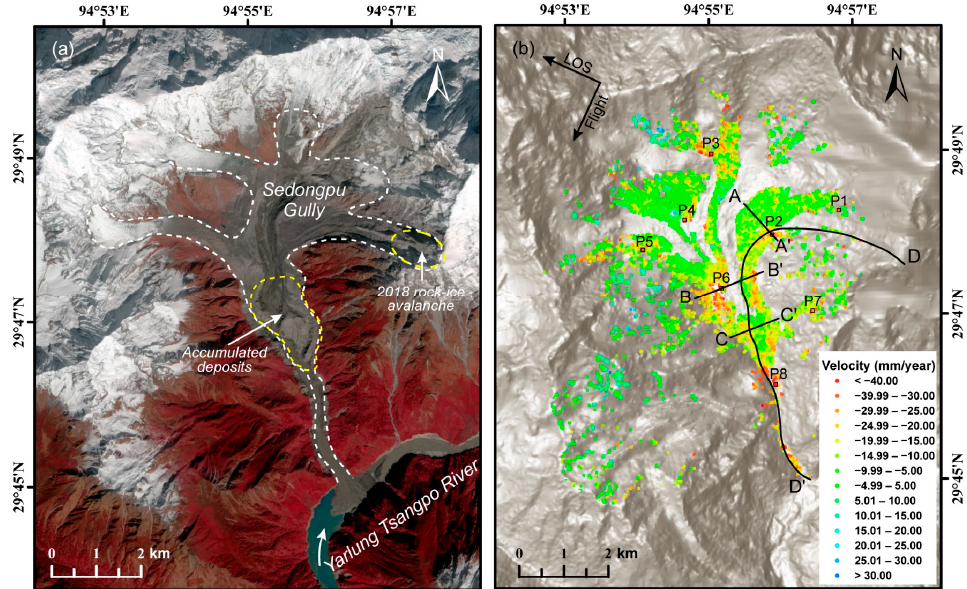
Figure 3. ( a ) Sentinel-2 image of Sedonpou Gully on 31 October 2018. The yellow dashed lines denote the source area where the ice avalanche occurred and the accumulation area of the pre-disaster deposits. ( b ) Map showing the annual average deformation rate in the LOS direction obtained by analyzing 55 Sentinel-1A descending-track images using the InSAR technique. Solid lines AA’, BB’, CC’, and DD’ indicate the locations of the profiles, which will be discussed later.